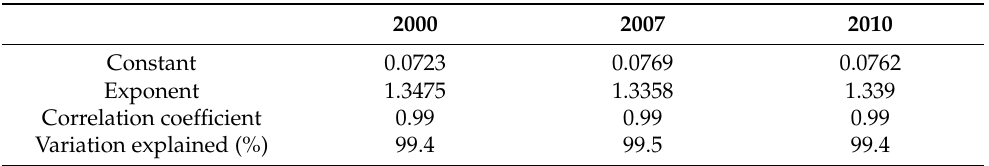
Figure 4. The power law relationship between total entrepreneurship and existing entrepreneurship of 1785 U.S. counties in 2000. Table 10. Power law relationships between total entrepreneurship and existing entrepreneurship of 1785 U.S. counties in 2000, 2007, and 2010.